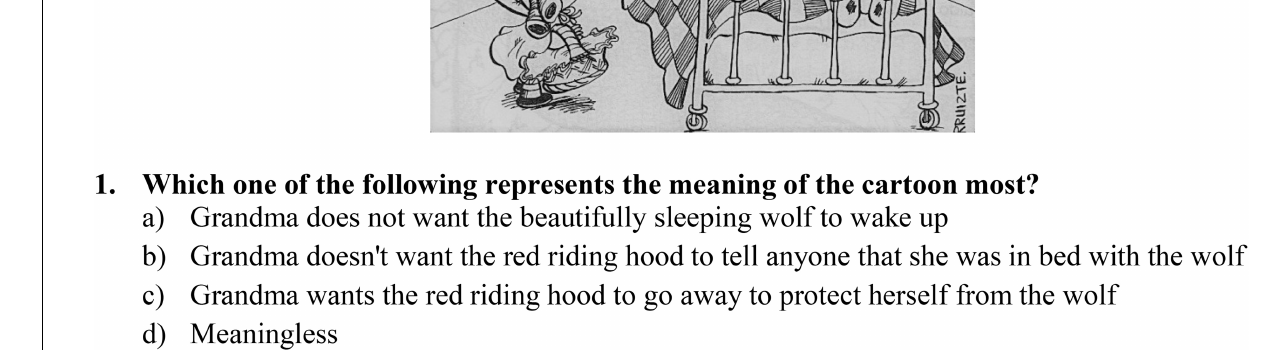
FIGURE 1 | Sample question from meaning-inference test. Option b represents the main meaning. Options a and c are secondary meanings. Option d is “meaningless.” Cartoon is reprinted with permission from the Aydın Do˘gan Foundation. Copyright© 1986, Aydın Do˘gan Foundation.